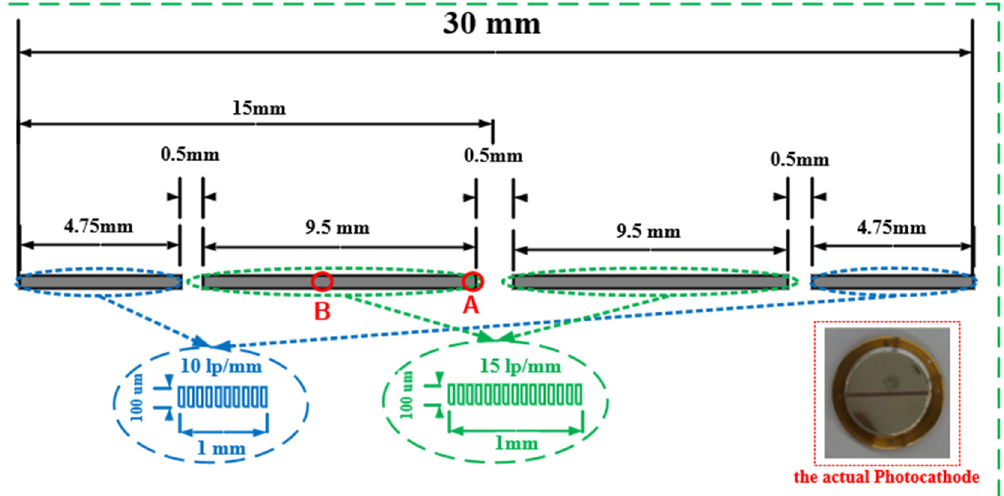
Figure 3. The structure and physical image of the streak tube used in the test: on the left is the internal structure diagram of the streak tube and in the lower right corner is the physical image of the streak tube. Table 1. Parameters of streak tube.